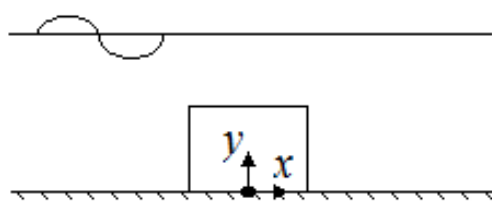
Figure 1. Breakwater system of this study.